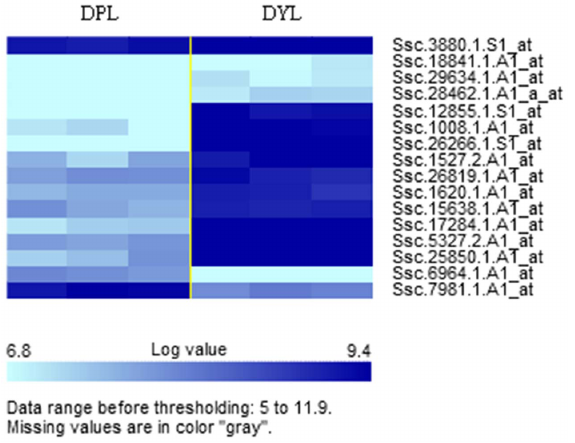
Figure 2. Clustered heat map of the statistically significant expressed genes identified between DPL- and DLY-infected pigs. Each column represents one pig, and each horizontal line refers to one gene. The three columns on the left and right represent the DPL and the DLY pigs, respectively. The color bar at the bottom of the figure indicates the expression level of the genes, those in the lightest blue have lower expression relative to the geometrical means, while dark blue indicates genes with higher expression relative to the geometrical means.